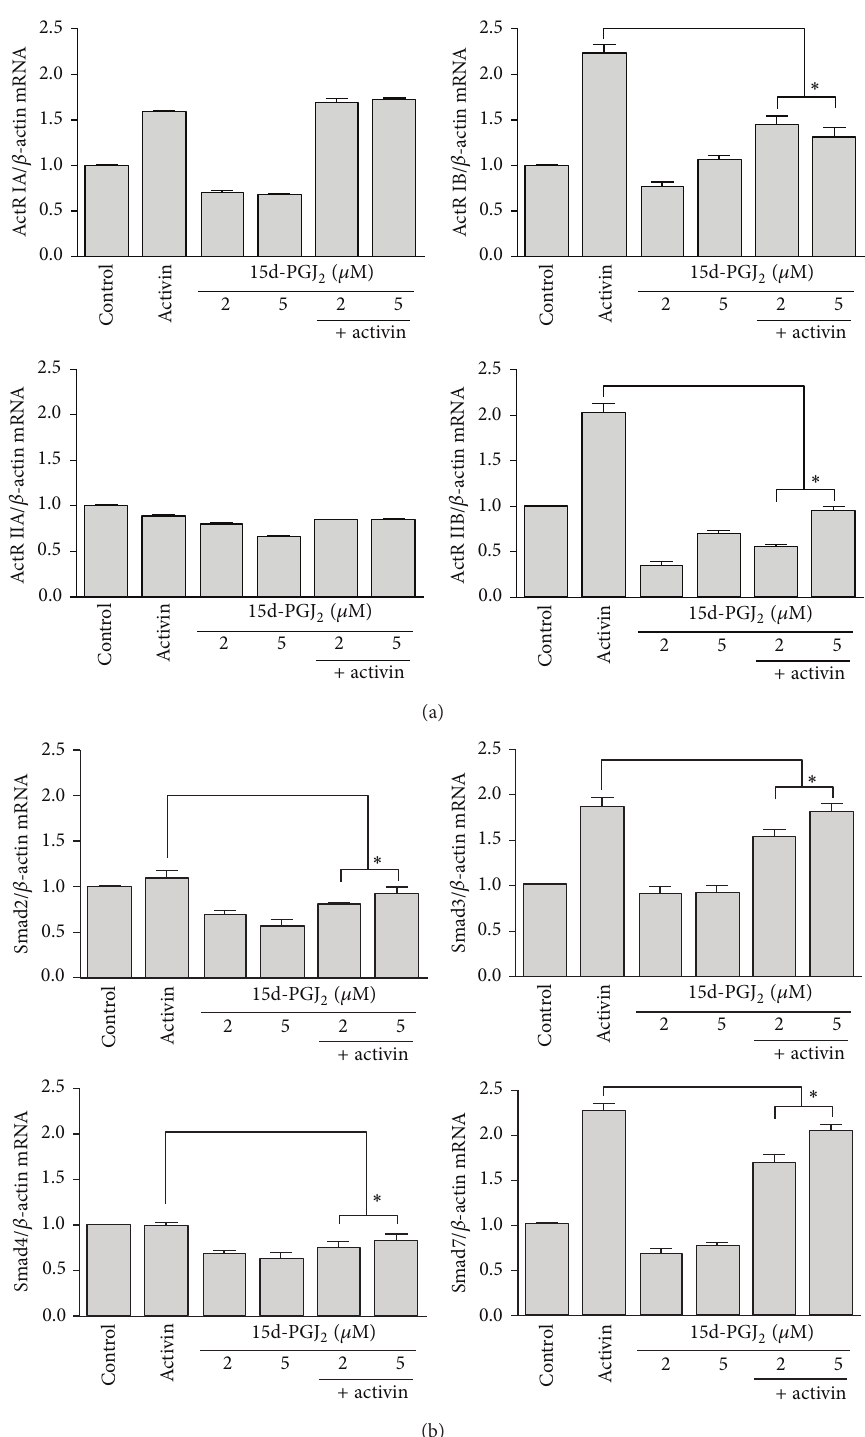
Figure 2: Activin receptor and Smad mRNA expression in HepG2 cells. HepG2 cells were treated with activin A (25ng/mL) and 15d-PGJ 2 (2 or 5 𝜇 M) for 72 h, and levels of ActR (a) and Smad (b) mRNA were measured by real-time PCR. The crossing point of activin receptors with 𝛽 -actin was entered into the formula, 2 −( target gene- 𝛽 actin ) , and the relative amounts were quantified. The data represent the mean ± SEM of 3 independent samples. ∗ 𝑃 < 0.05 , comparison of stimulation with 15d-PGJ 2 and activin A versus activin A stimulation